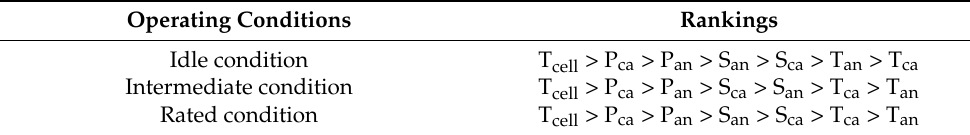
Table 6. Parameter sensitivity rankings.